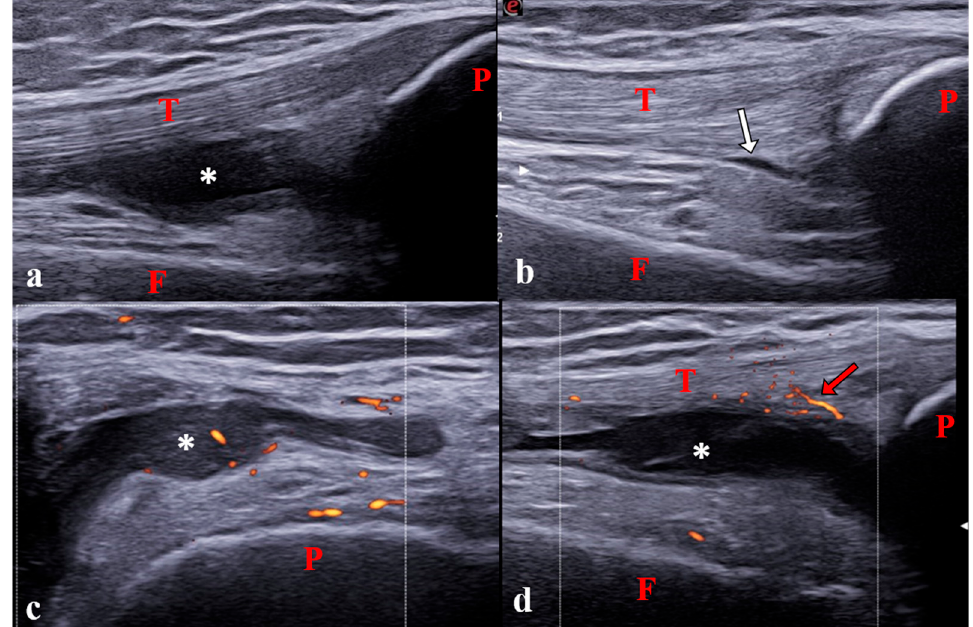
Figure 2. Synovitis of the knee joint in a 12-year-old girl with polyarticular juvenile idiopathic arthritis. ( a ) Longitudinal suprapatellar scan showing synovitis in the suprapatellar recess on B-mode (grade 2). ( b ) Physiological aspect of the contralateral joint on B-mode. ( c ) Transverse lateral parapatellar scan showing pathological vascularization (power Doppler grade 1). ( d ) Longitudinal suprapatellar scan showing vascularization outside the synovial hypertrophy (power Doppler grade 0). Note that the transverse scan is more sensitive for detecting pathological vascularisation inside synovitis than the longitudinal scan [18]. P: patella; T: tendon; F: femur; *: Synovitis; white arrow: small physiological amount of intra-articular fluid; Red arrows: physiological vascularization.